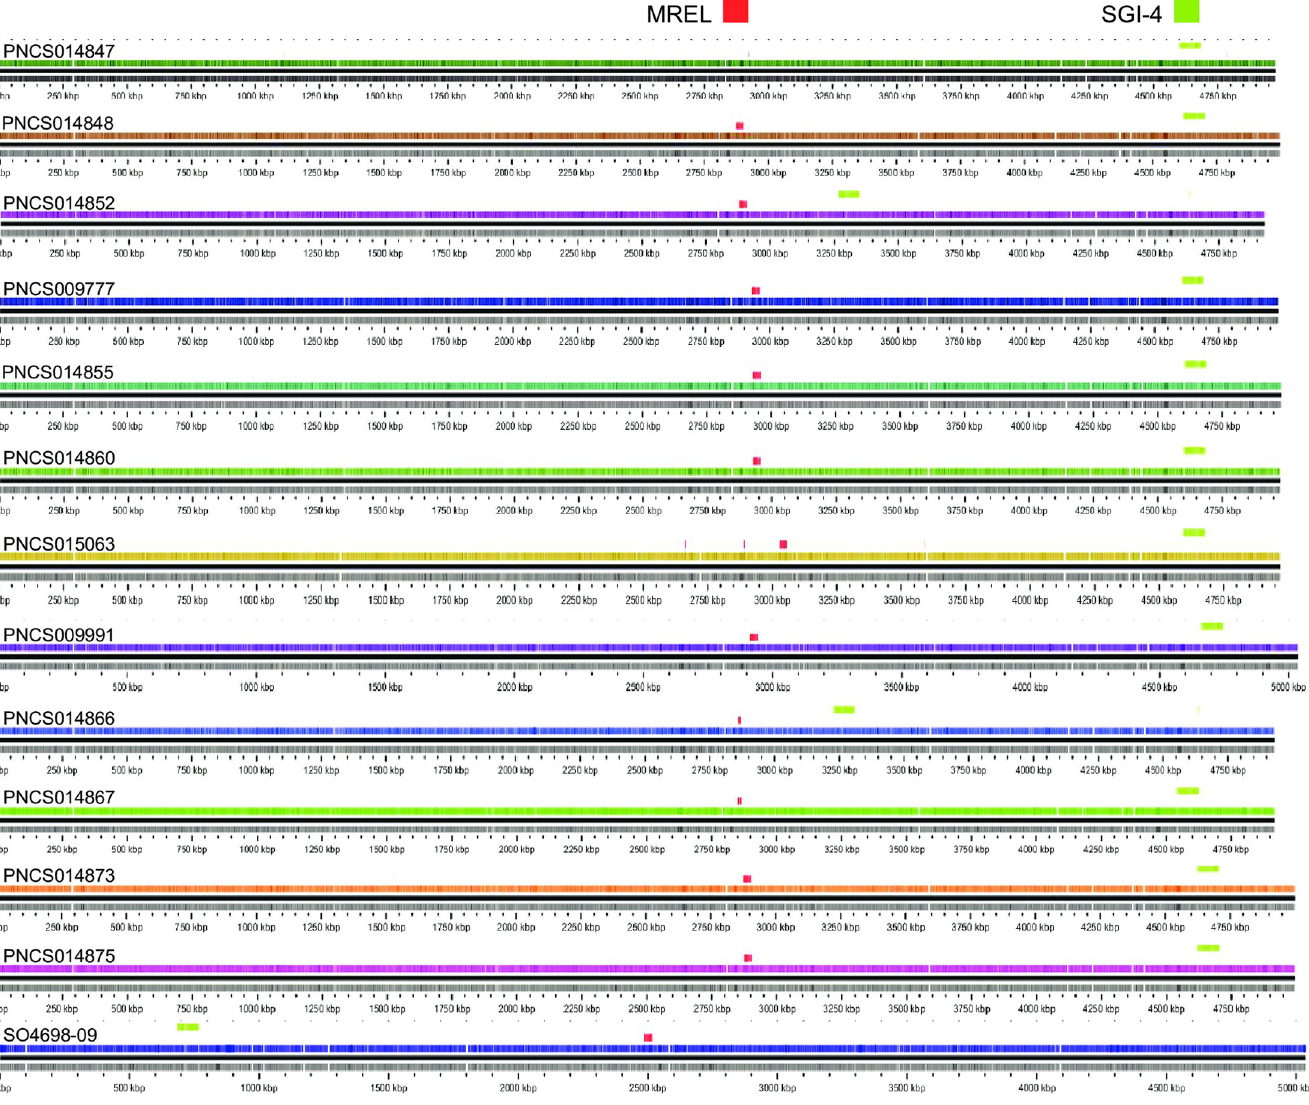
PLOS ONE | https://doi.org/10.1371/journal.pone.0236436 July 27,